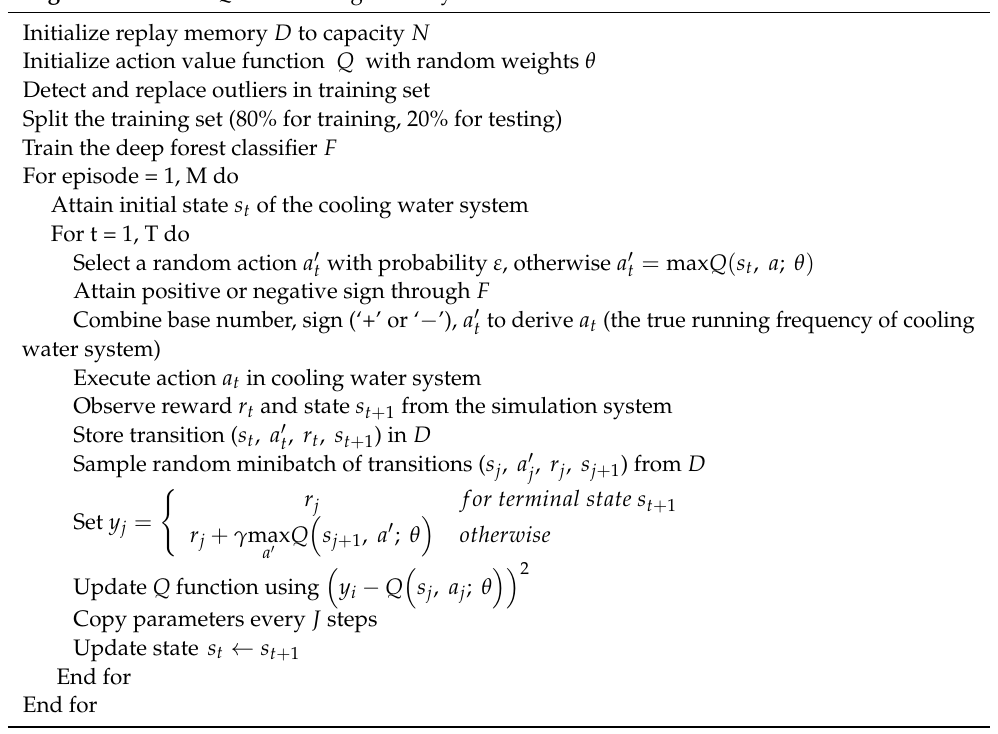
Algorithm 1. DF-DQN for cooling water